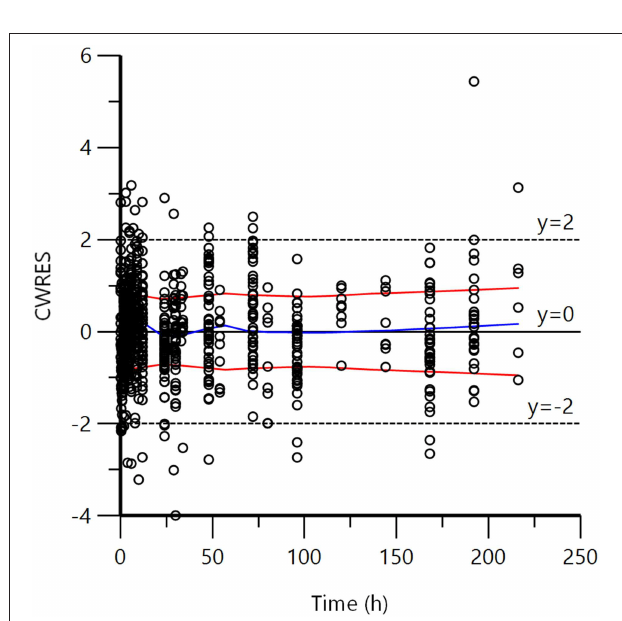
FIGURE 4 | Plot of CWRES (conditional weighted residuals) against time after dose (h). Values of CWRES should be approximately N (0, 1) and hence concentrated between y = − 2 and y = + 2. Inspection of the figure shows that data were evenly distributed about zero (see the trends as given by the blue line) and the red line (with its negative reflection) did not show any fanning, indicating no bias in the structural